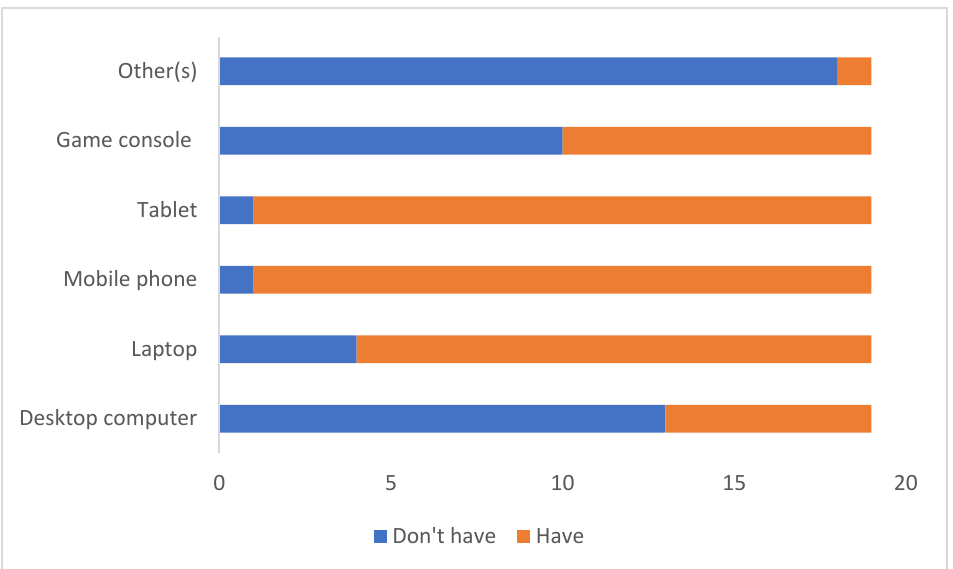
Figure 1. 7th grade s tudent’s ownership of digital devices .